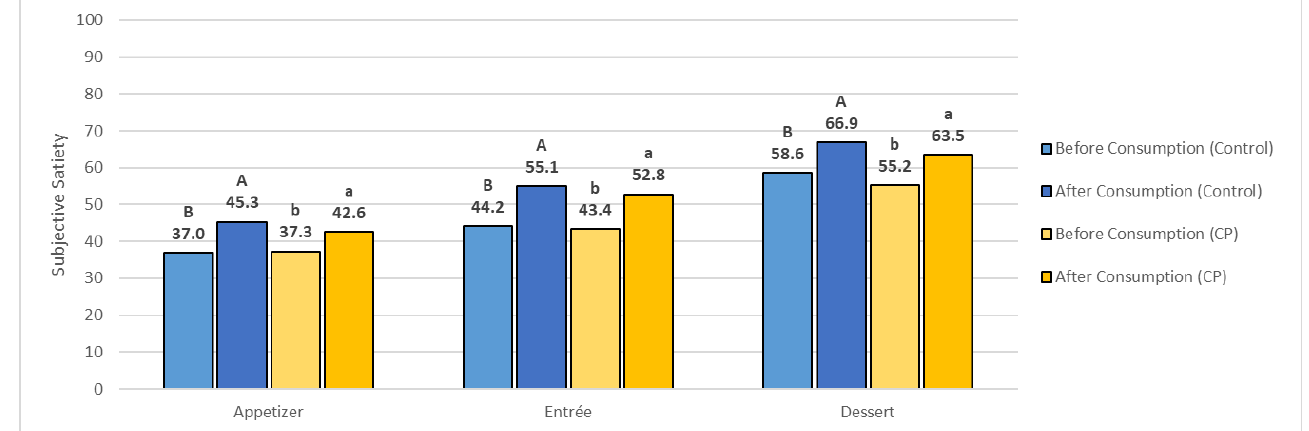
Figure 4. Mean subjective satiety reported by the participants, using the SLIM scale [76], before and after the consumption of each dish. Bar graphs were colored blue for the Control dishes and yellow for the CP dishes. Differentiating letters (uppercase for Control, lowercase for CP) shows a significant difference was found between the before and after subjective satiety using a two-way ANOVA, blocked on Product Evaluation (Product Before and After) and Participant, for each dish ( p < 0.05).